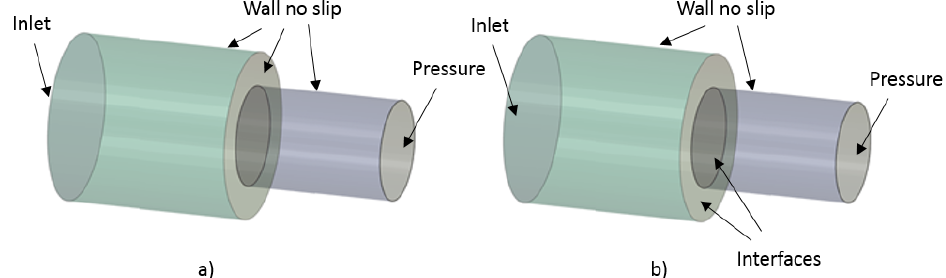
Figure 9. Boundary conditions: ( a ) matched grid model, ( b ) unmatched grid model.